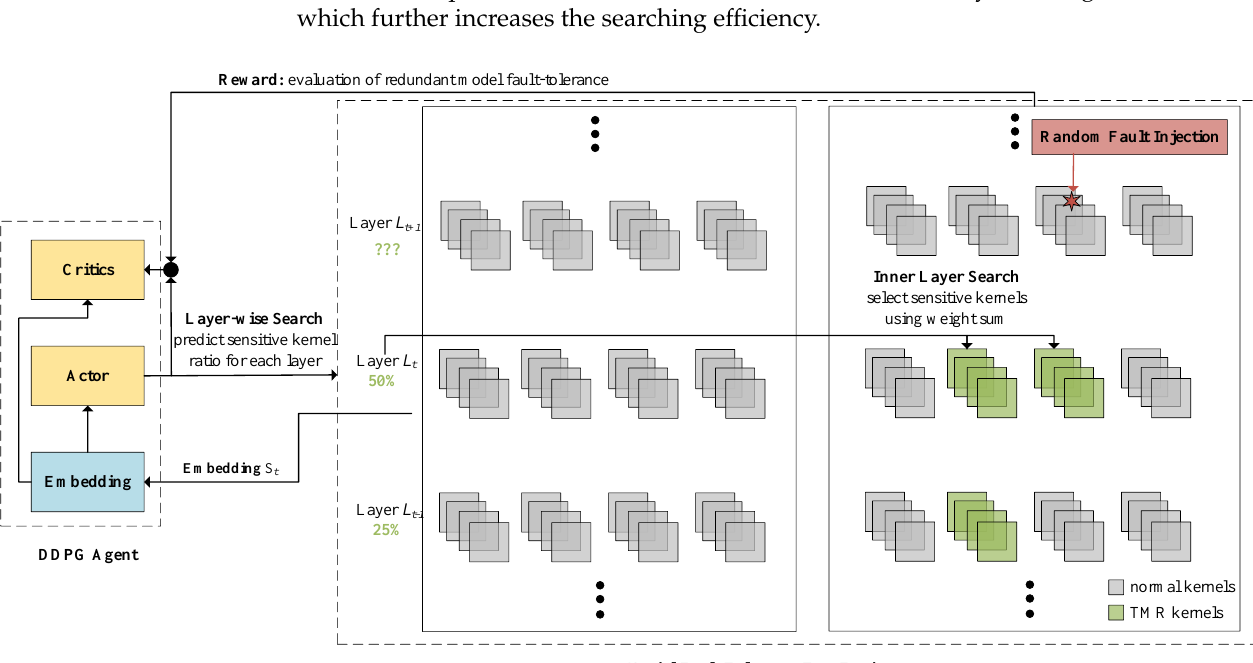
Figure 8. Demonstration of the AMHR framework. The DDPG agent first performs a layerwise search to predict the ratio of error-sensitive kernels for each layer, and the inner layer search then follows to pinpoint the exact positions of the kernels with the weight-sum method. The fault tolerance of the hardened model is evaluated in a fault injection test